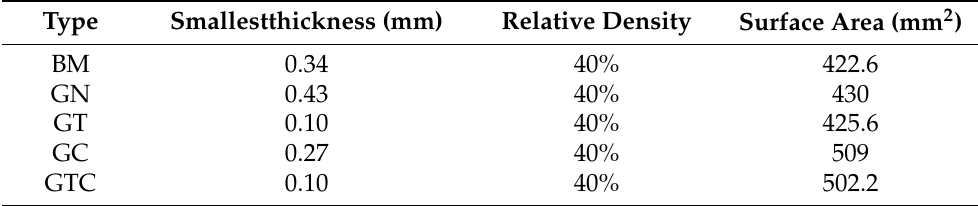
Table 1. Model parameters of samples.